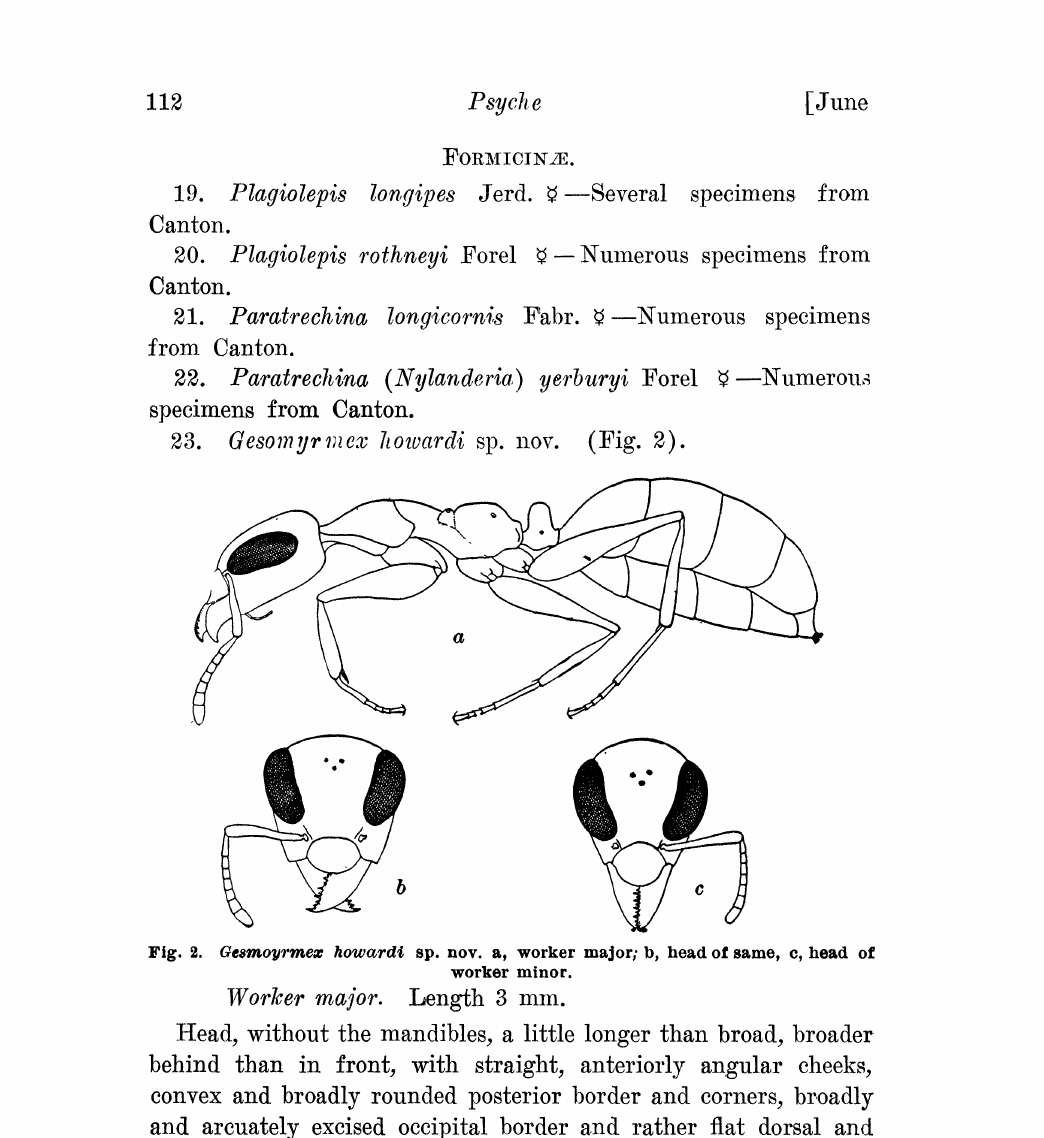
Fig. i. Gesmoyrme howardi sp. nov. a, worker major; b, head of same, c, head of worker minor. Worlcer major. Length 3